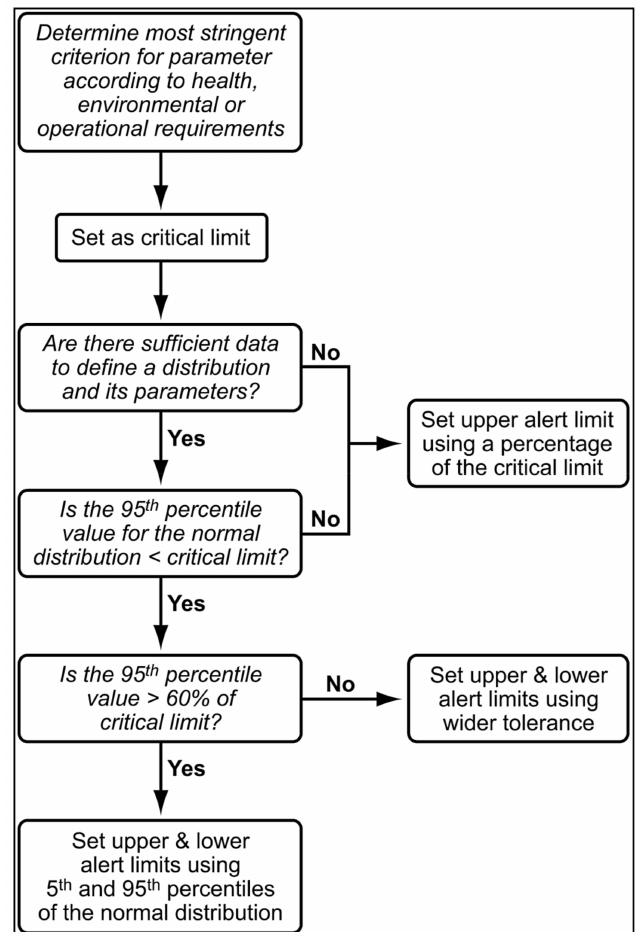
Figure 1. Methodology based on a decision-tree approach for determining critical limits for water quality and setting alert limits from Gonzalez et al. [110] with permission from